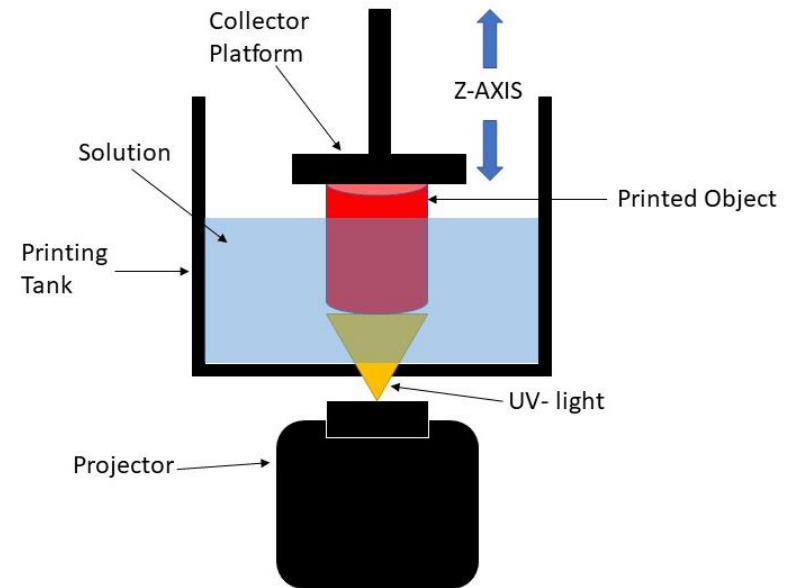
Figure 1. Schematic diagram of DLP 3D printing process.